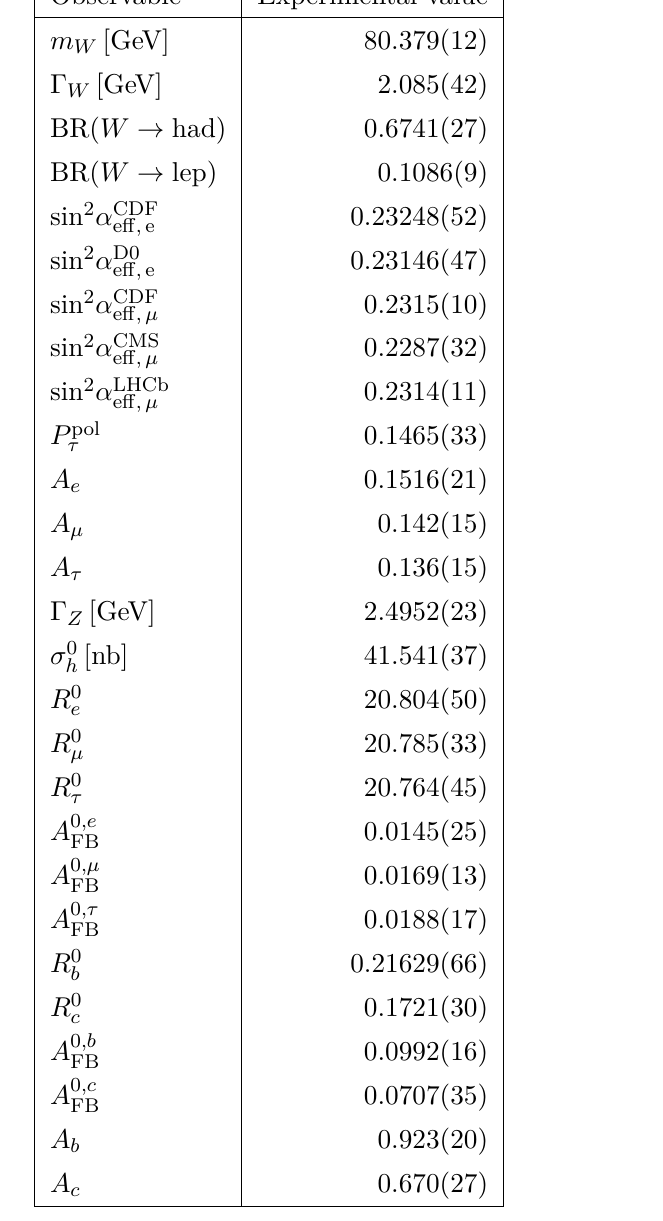
Table 1. Electroweak observables [206, 207] used in our fit which are calculated by HEPfit [135] using m L , α and G as F Z